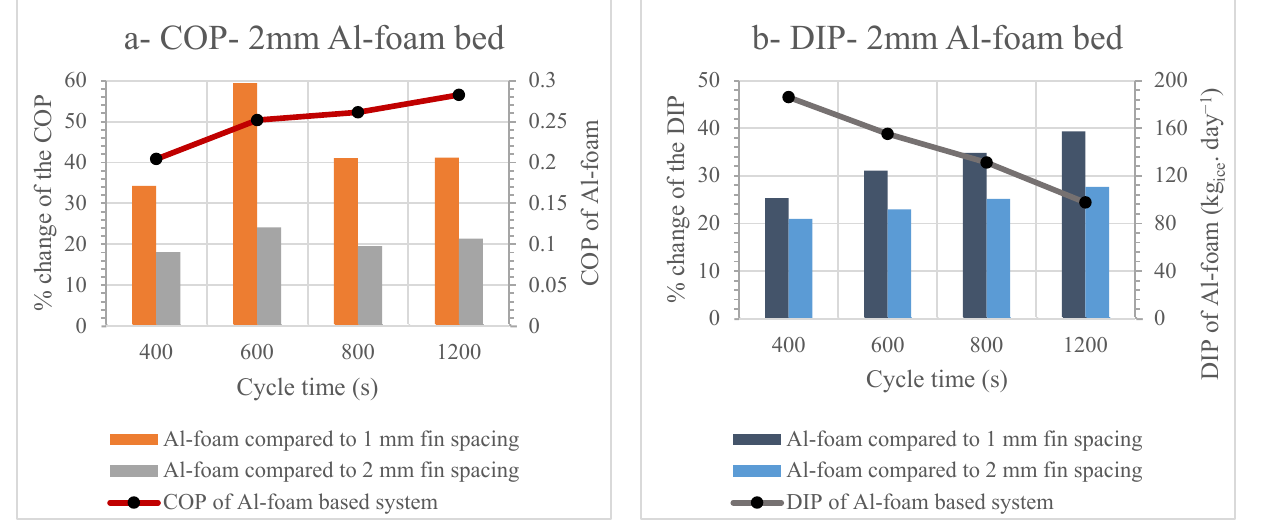
Figure 6. Effect of the cycle time on the percentage change in the system COP and DIP when using Al-foam bed with 2 mm thickness. ( a ) COP, ( b ) DIP.